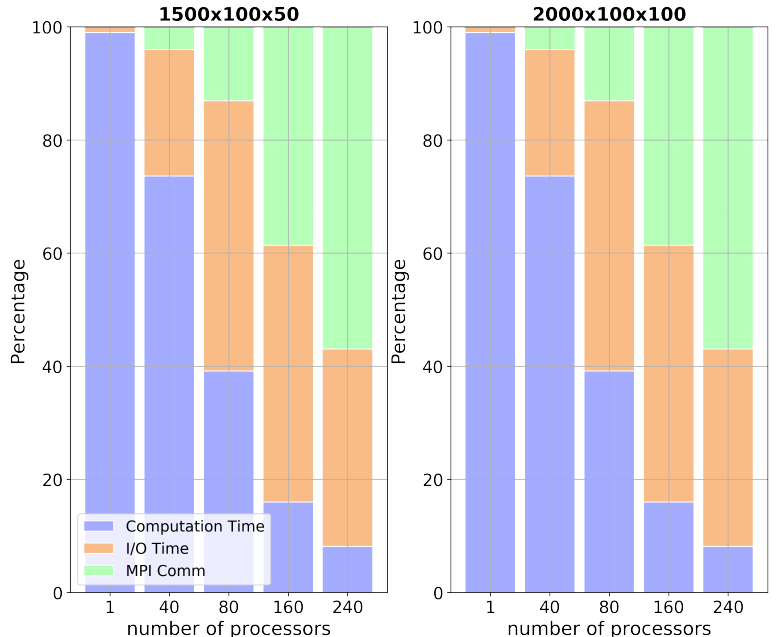
Figure 6. Stacked normalized plot of the time partitioning for the lower resolution